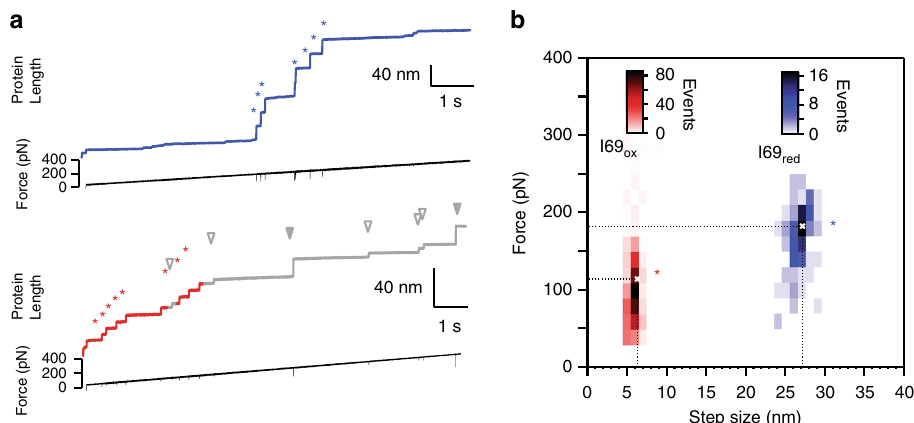
Fig. 4 Disul fi de bonds decrease the mechanical stability of titin Ig domains. a Typical unfolding traces of (I69) 8 recorded with a linear force increase of 40 pN s − 1 . Blue asterisks mark the unfolding events of I69 reduced (26 nm steps in the blue upper trace) whereas red asterisks correspond to unfolding steps of I69 oxidized (6 nm steps in the red lower trace). Isomerization reactions are detected as additional steps (gray triangles). b Unfolding forces and step sizes are represented in a bidimensional histogram. Average values appear as